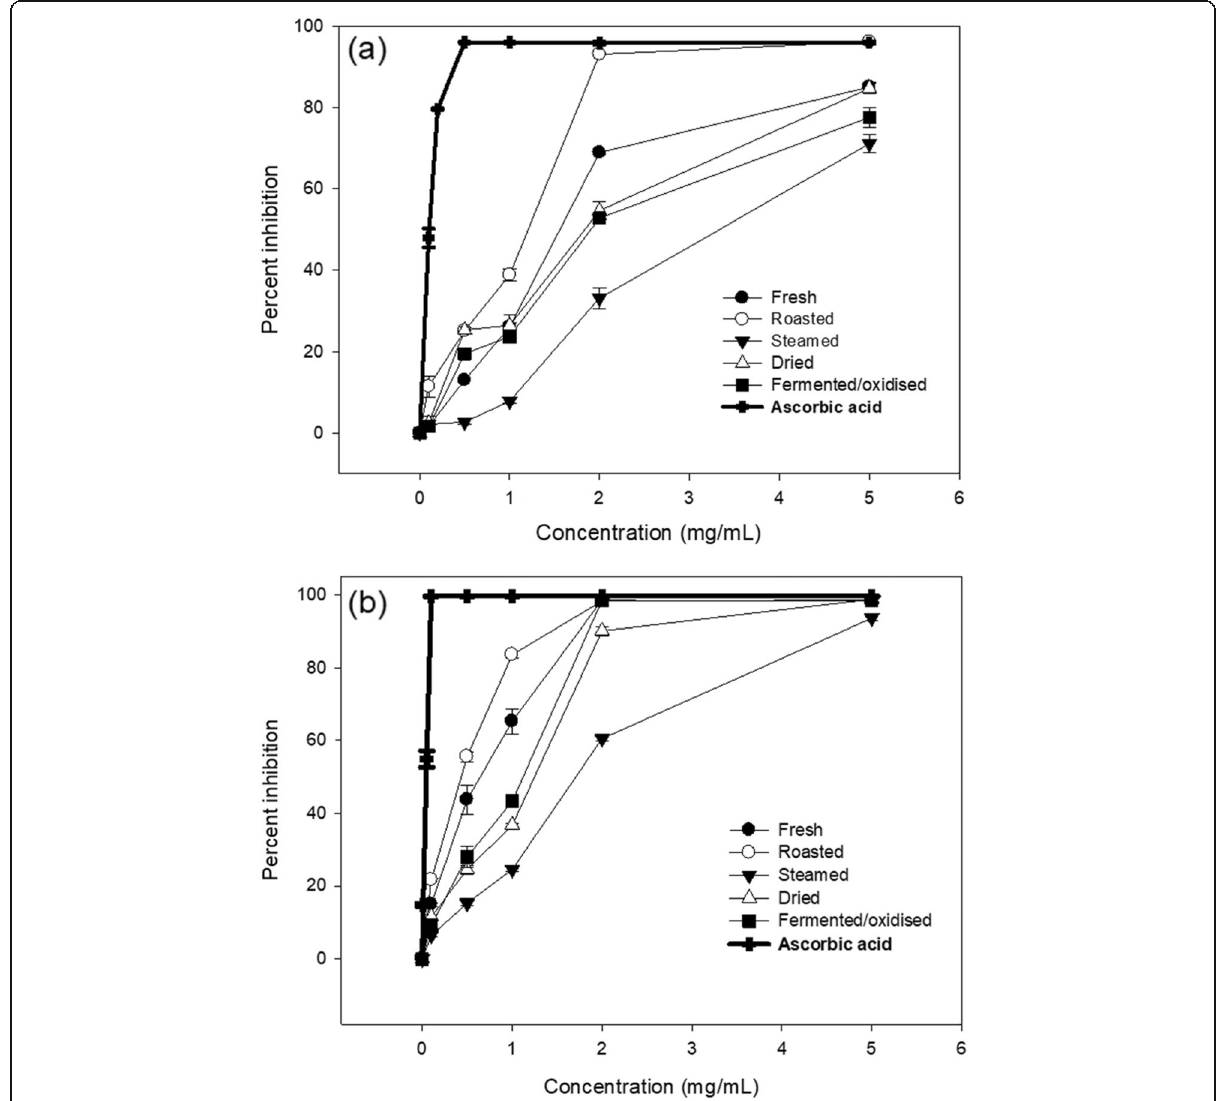
Fig. 3 Free radical scavenging activity in fresh and processed leaf extracts of Moringa oleifera. a DPPH scavenging activity; b ABTS scavenging